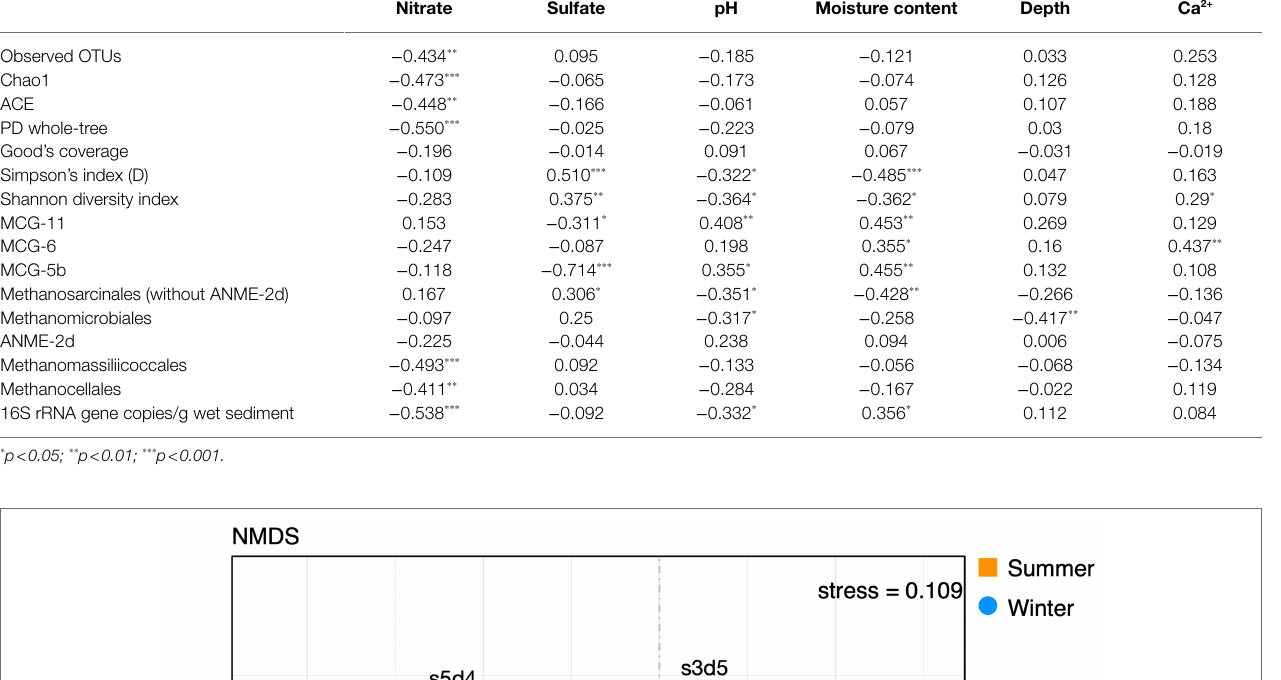
A redundancy analysis (RDA) based on phylum-level archaeal relative abundance indicated that the first two axes of the plots explained 99.6 and 0.31% of the variance of the whole archaeal community, respectively ( Figure 6 ). The moisture